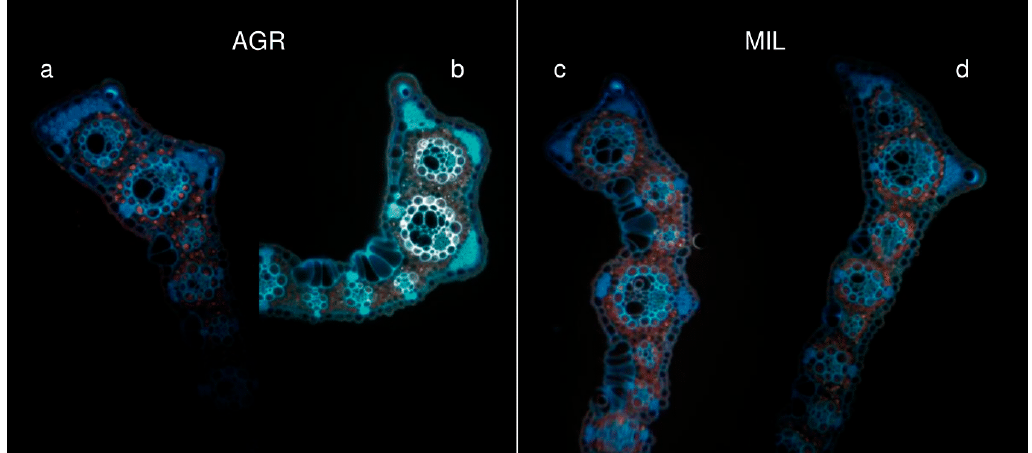
Figure 7. Differences of leaf shapes (5 cm from tip), inner part of the leaf (a, c), outer part of curled leaf (b, d)